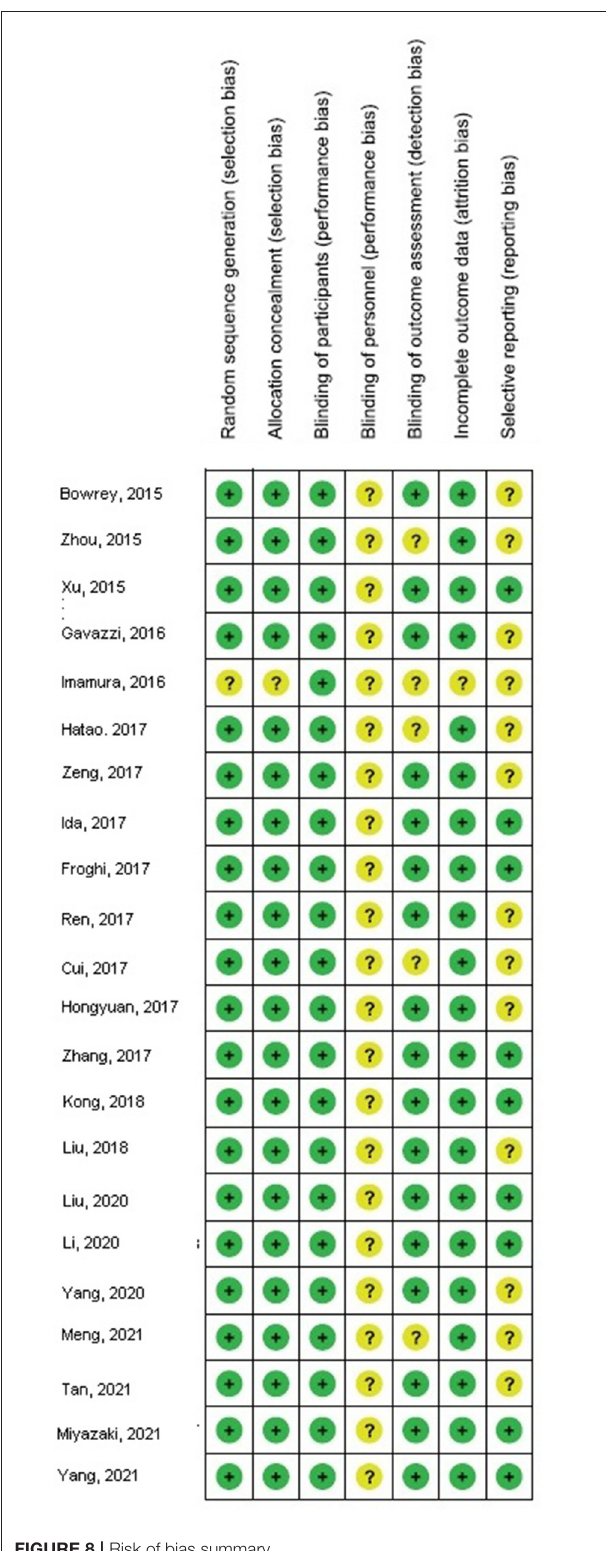
FIGURE 8 | Risk of bias